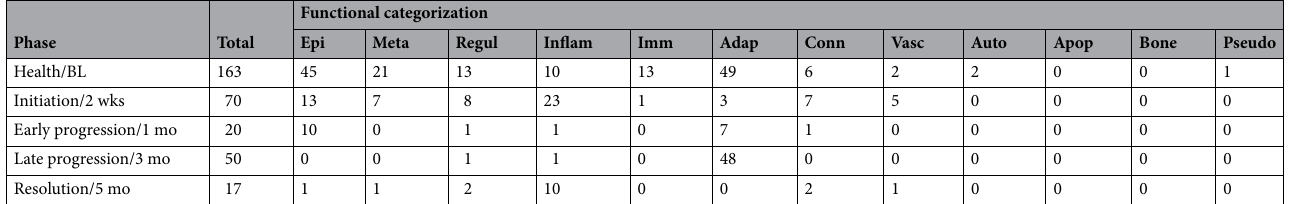
Table 2. Identification of altered gene expression in gingival tissues, with functional patterns unique to each phase of health, disease and resolution by comparison to gene expression profiles in all other phases of lesion formation and resolution. Value denote number of genes represented in each category. Fxn denotes functional categorization of genes: Epi epithelium, Conn connective tissue, Bone, Meta metabolic, Regul regulatory,